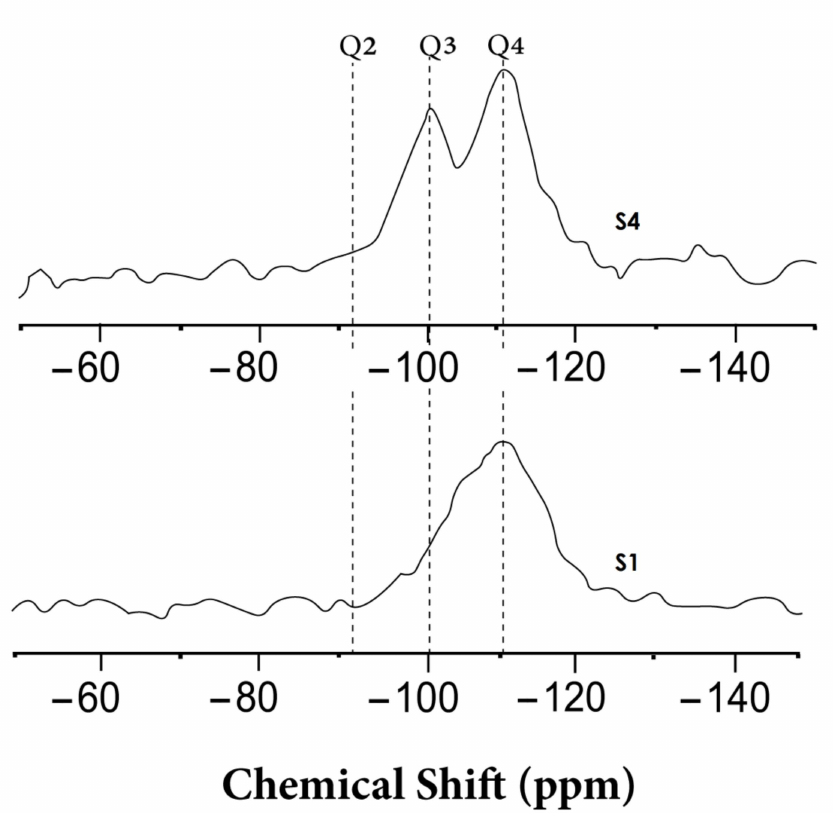
Figure 7. Local ordering of the starting form of a-silica S1 and after reaction time of 312 hours (S4): 29 Si MAS NMR spectra, where the x-axis shows the chemical shift in parts per million (ppm) and the y-axis corresponds to the intensity scale of each spectral line in arbitrary